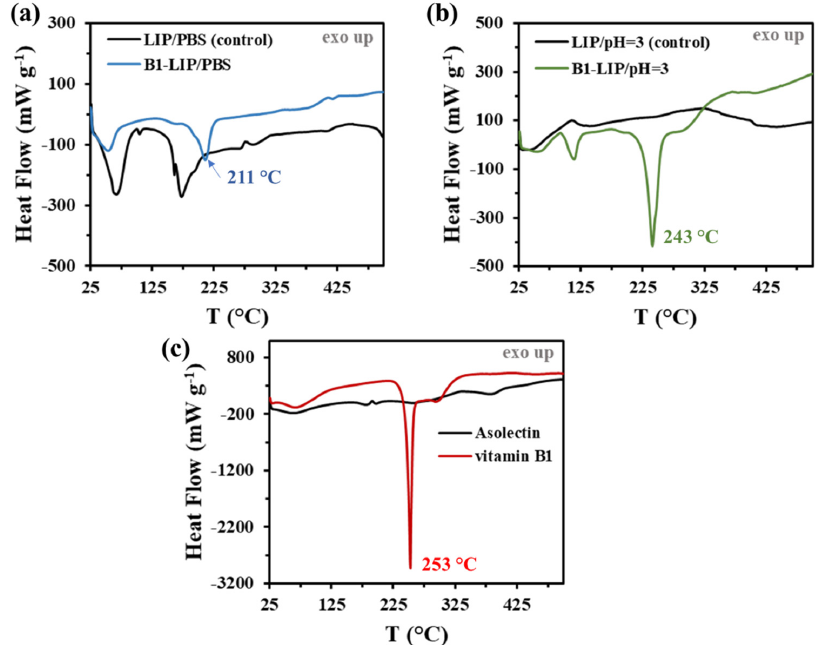
Figure 3. DSC curves of the vitamin-loaded LIPs under ( a ) physiological (pH = 7.4 and 0.15 M NaCl) and ( b ) acidic (pH = 3.0 and 0.20 M KCl) conditions, as well as ( c ) the DSC curves of the pure vitamin B 1 and the initial asolectin